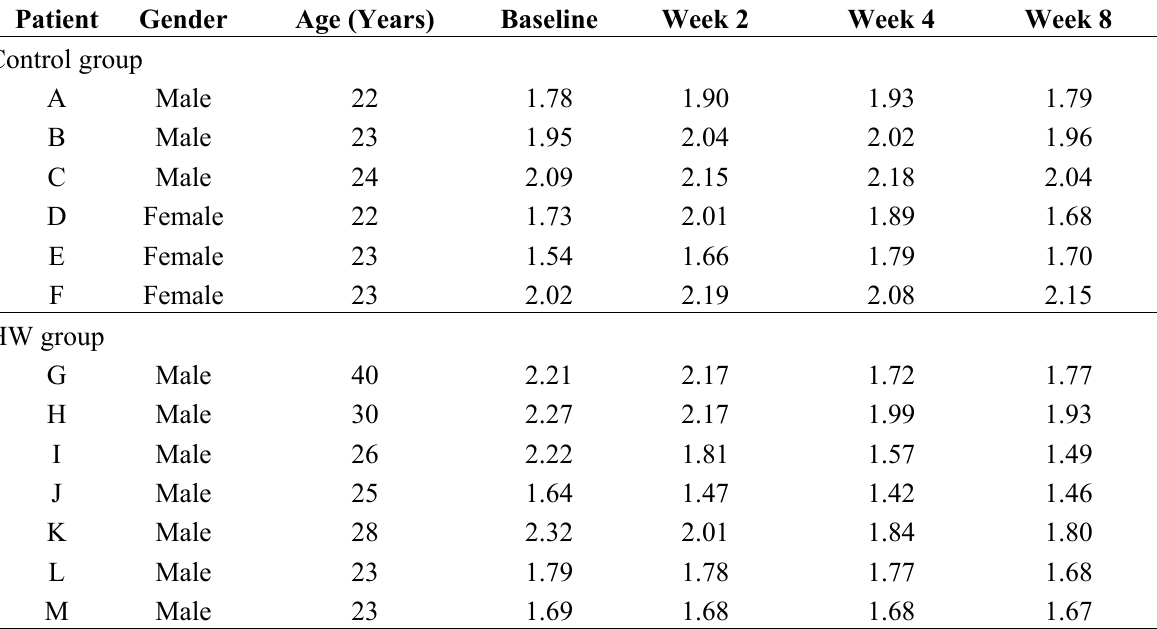
Table 3. Changes in CAL in each individual